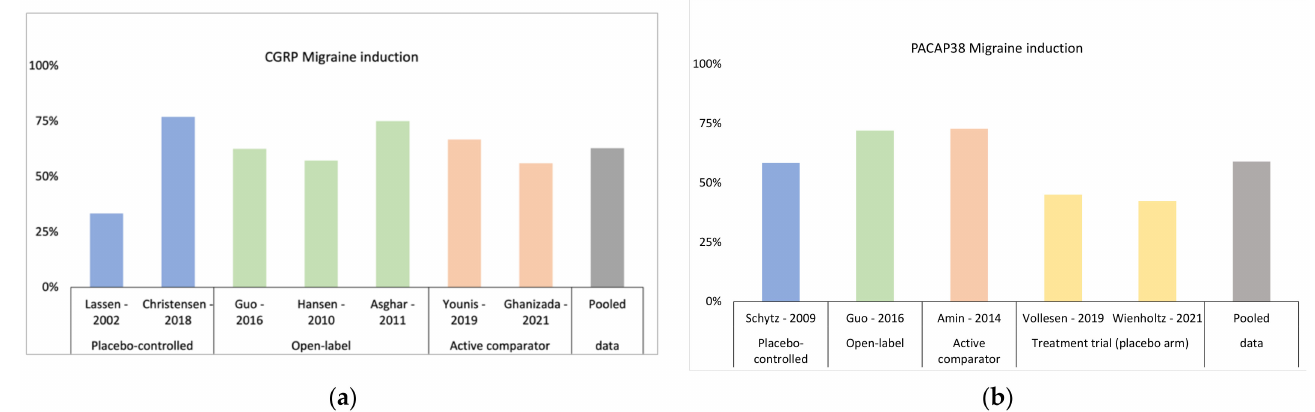
Figure 1. Migraine induction rates in the various provocation studies investigating migraine using calcitonin gene-related peptide (CGRP) ( a ), and pituitary adenylate cyclase-activating polypeptide-38 (PACAP38) ( b ), divided into study setups. “Active comparator” denotes the fact that each peptide was tested against another provocation model and “treatment trial” indicates that data has been extrapolated from the placebo arm of a study that sought to inhibit migraine induction by